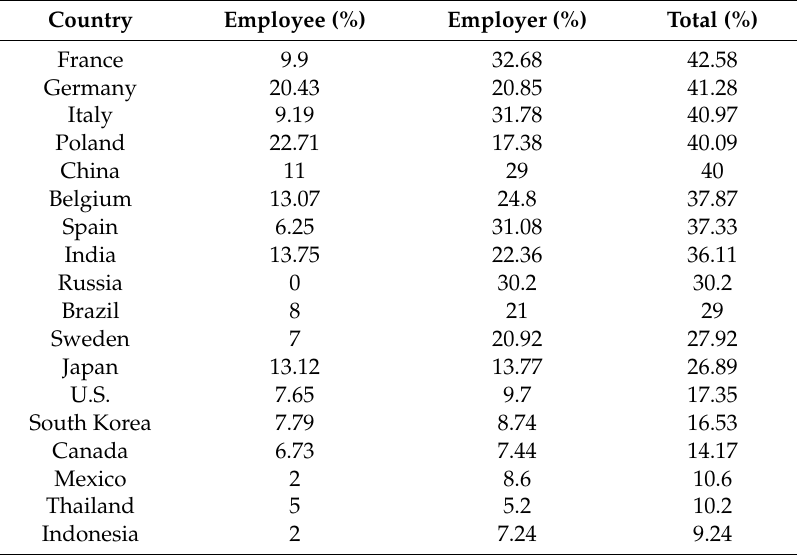
Table 1. The social insurance contribution rates in selected